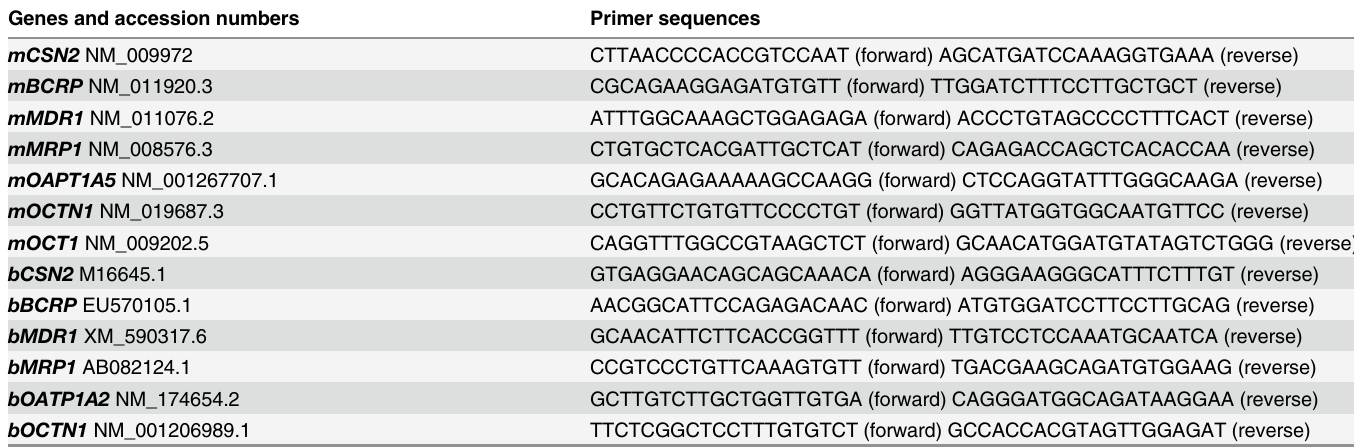
Table 1. Primer sequences used for the RT-qPCR analyses. Abbreviations, m: murine; b: